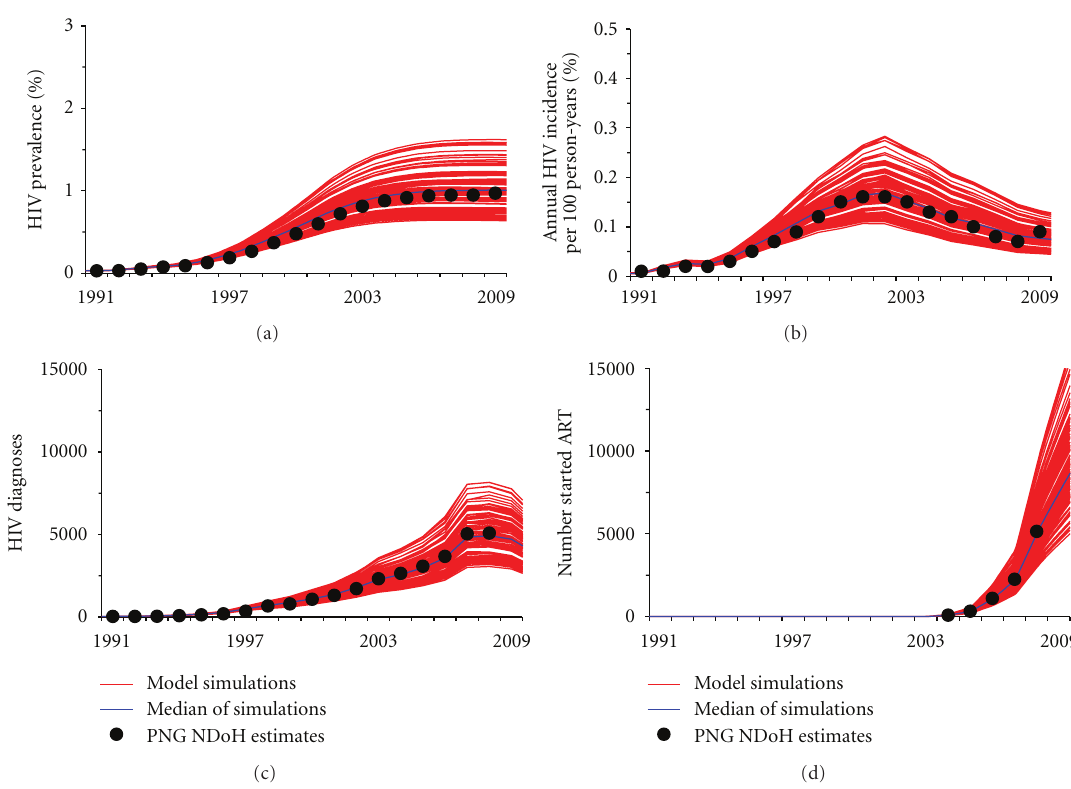
Figure 2: Fitting and calibration of the HIV transmission model to PNG epidemiological data from 1990 to 2009. In each figure, estimates or data from the PNG National Department of Health (black discs, data) are compared with 100 model-based simulations (red) and median simulations (blue) over the period from 1990 to 2009. (a) HIV prevalence in adult population. (b) HIV incidence each year per 100 persons. (c) Number of HIV diagnoses each year. (d) The cumulative number of HIV-infected people who have started antiretroviral treatment by the end of each